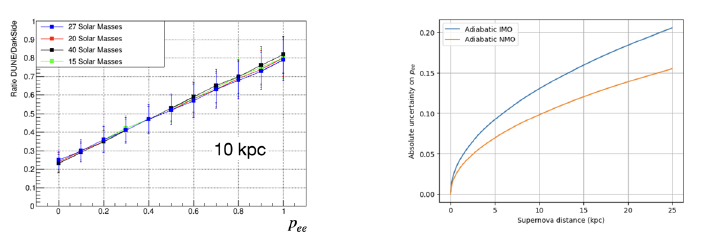
as a function of p ee for a CCSN at 10 kpc. Right: Uncertainty on the measured p ee Figure 2. Left: R ′ as a function of the CCSN distance in the NMO and the